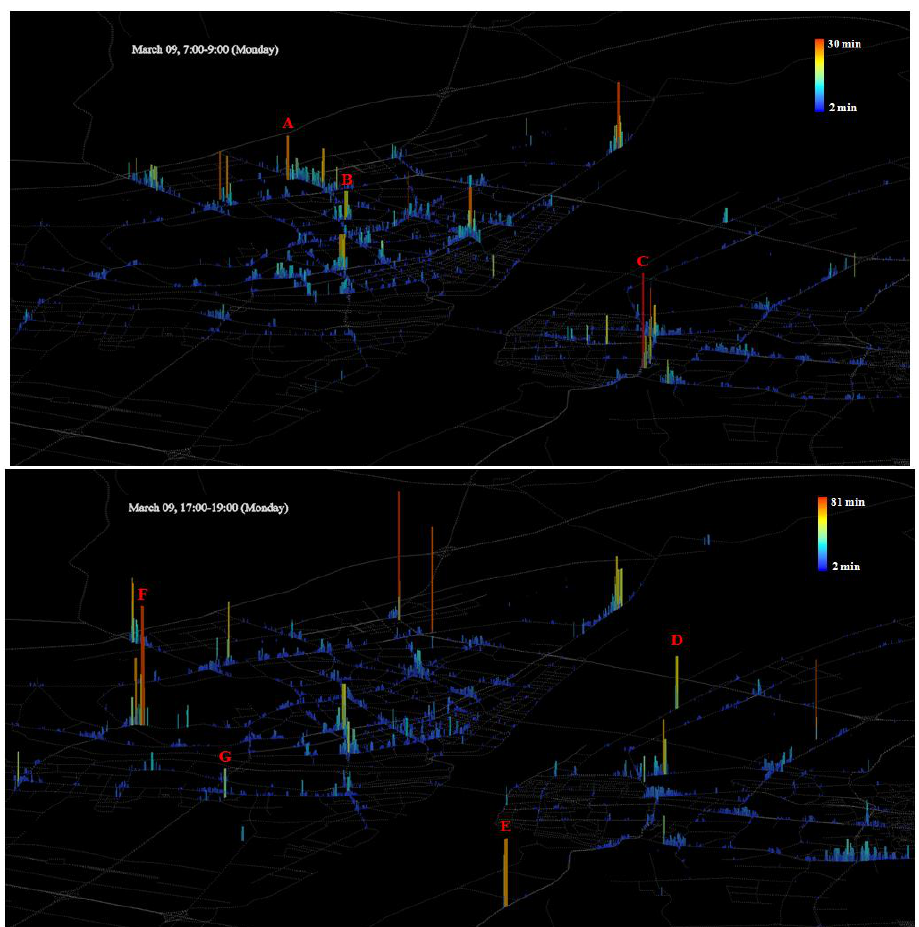
Figure 9. Spatio-temporal clusters visualized according to their lifetime during rush hour: the more red, the longer the duration of traffic